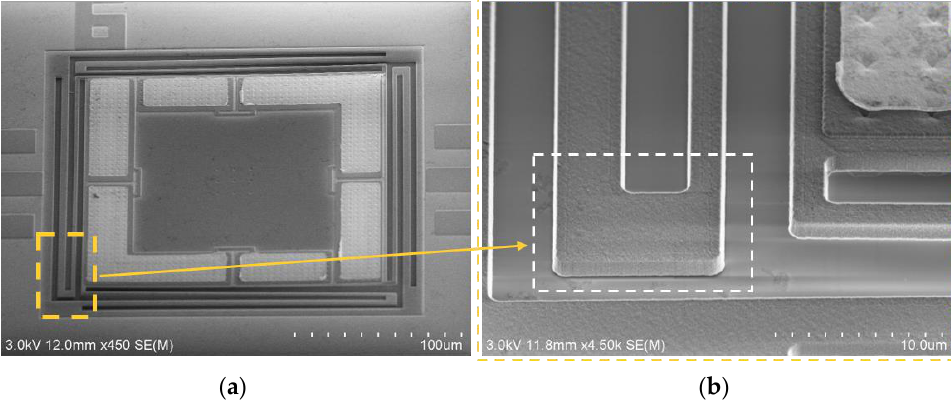
Figure 9. Scanning electron microscopy (SEM) view of the temporary supported beam of the fabricated tactile sensor. ( a ) SEM view of the fabricated tactile sensor; ( b ) enlarged view of the temporary supported beam shown in Figure 9a.